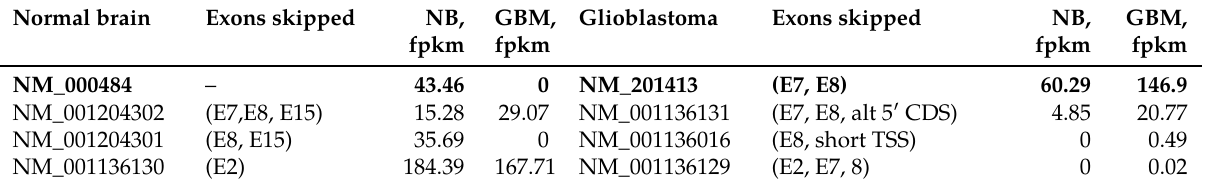
Table 2: Pairs of closest by structure isoforms of APP gene ordered by expression rate difference (See Figure 3). Normal